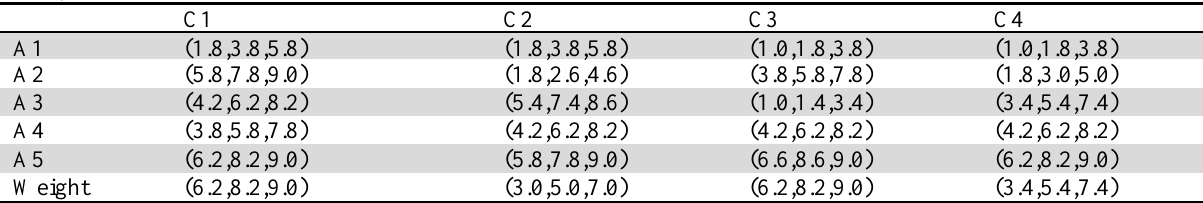
Fuzzy decision matrix for MIS